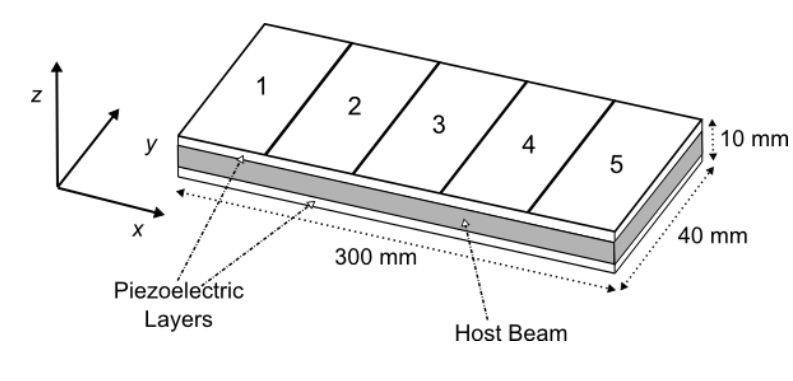
Figure 2. The smart beam